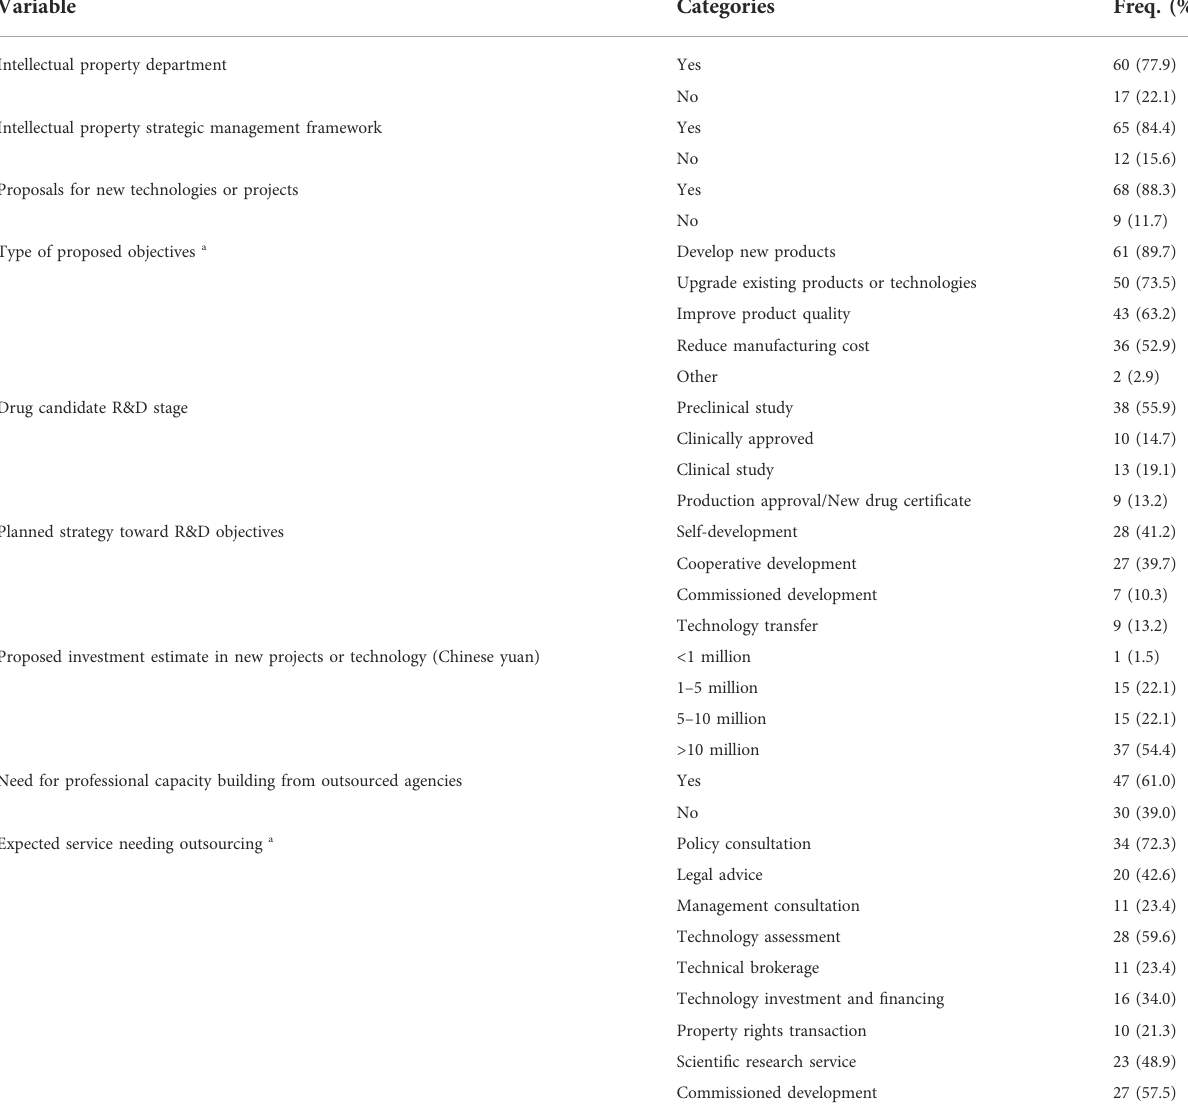
TABLE 5 New technology, intellectual property, and factors that promote the development of